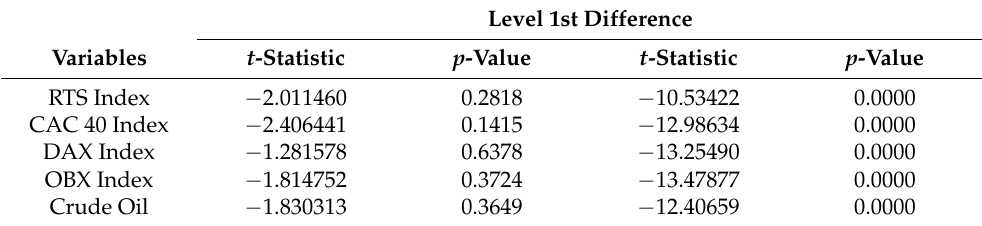
Table A2. Augmented Dickey–Fuller Test Results (Pre-Vaccine Period).